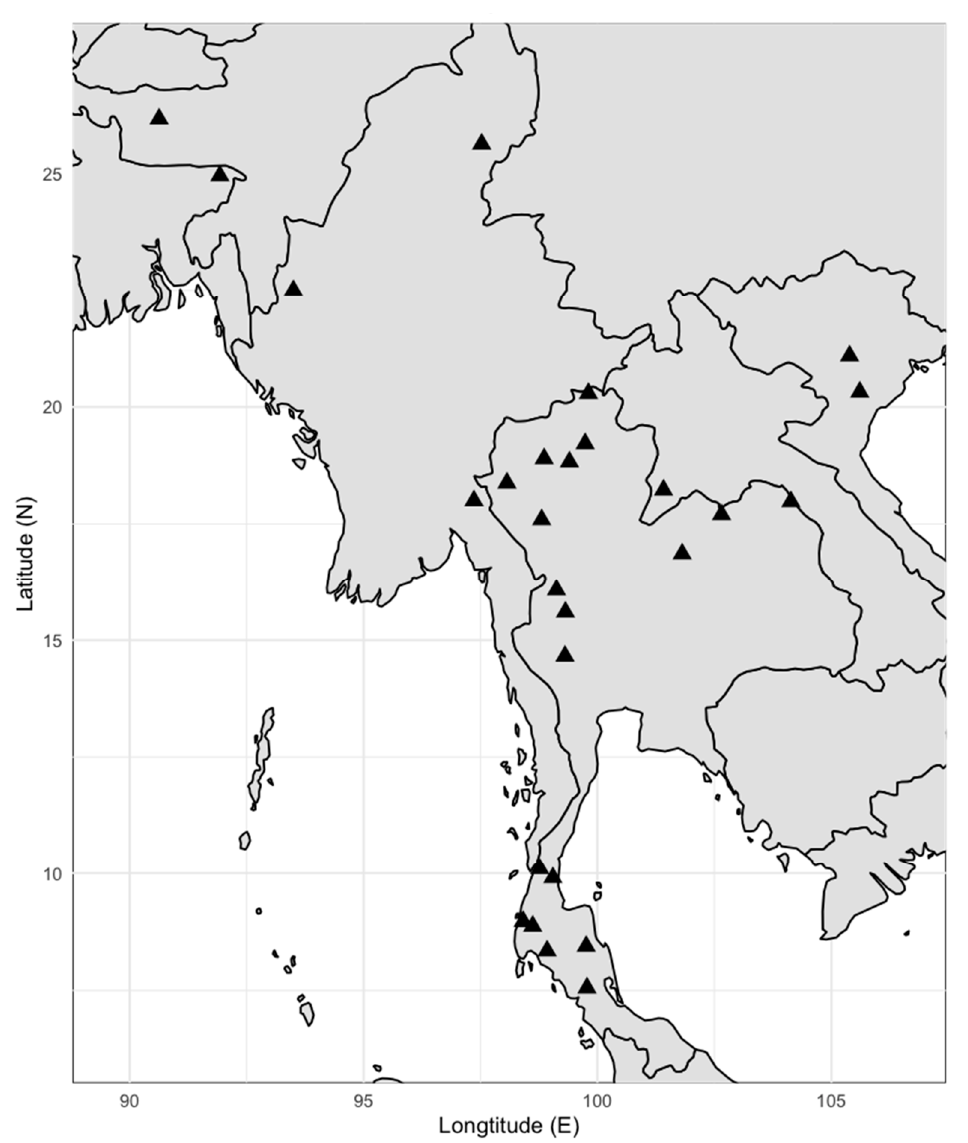
Figure 13. Distribution of Garcinia pedunculata .